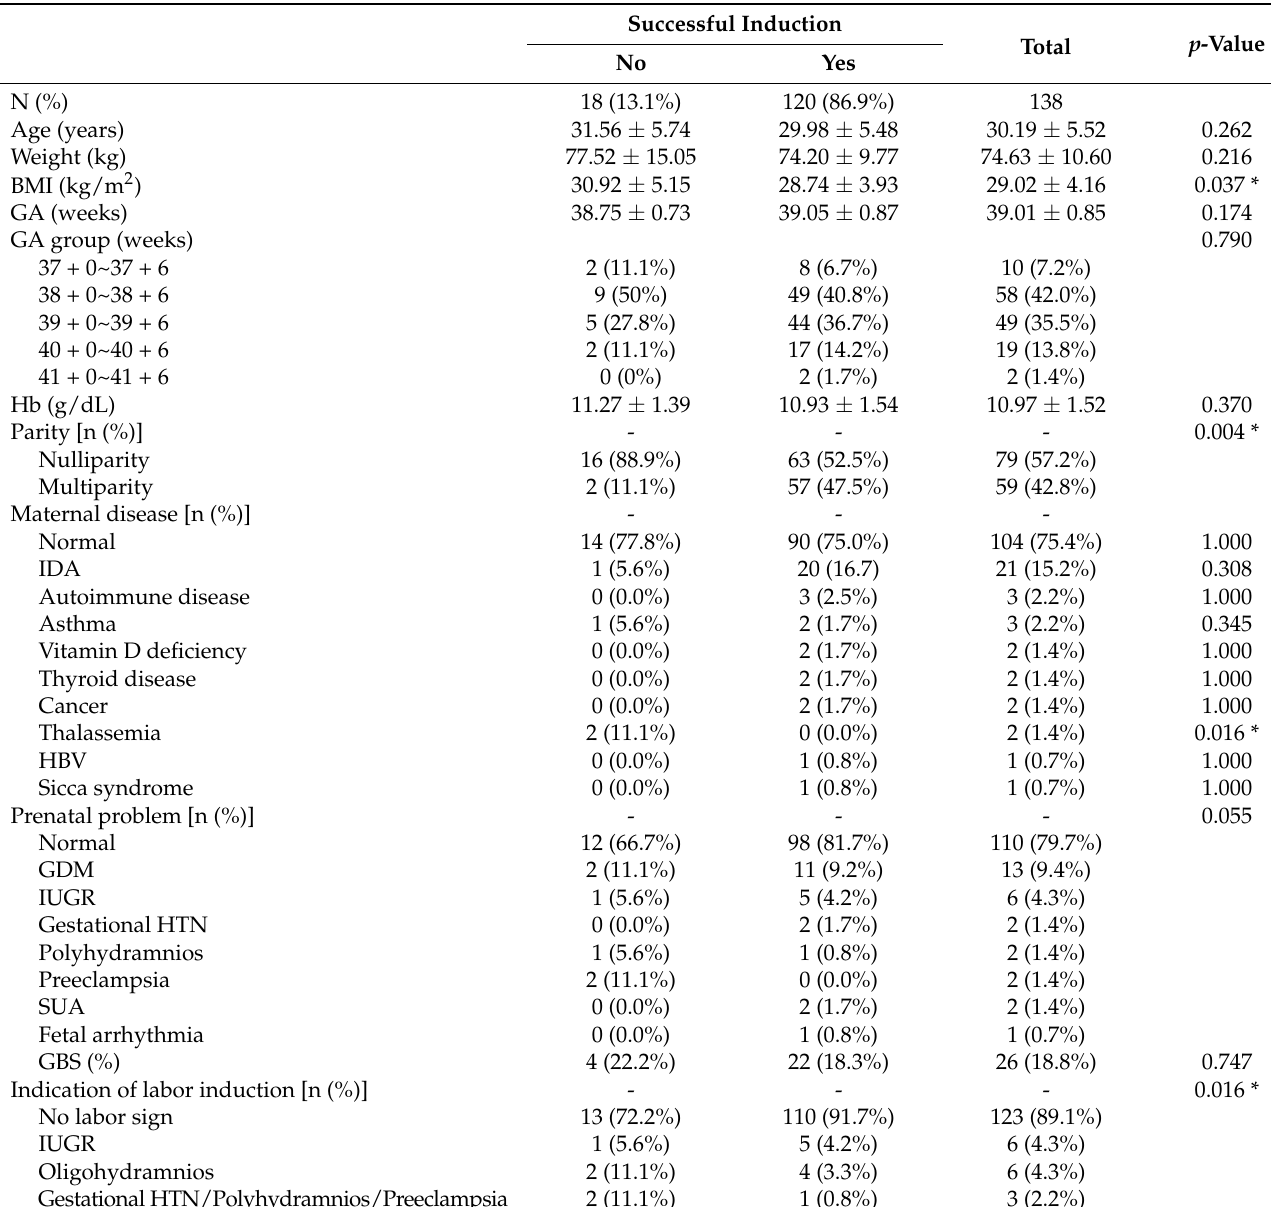
Table 1. Demographic characteristics of the study population (n =